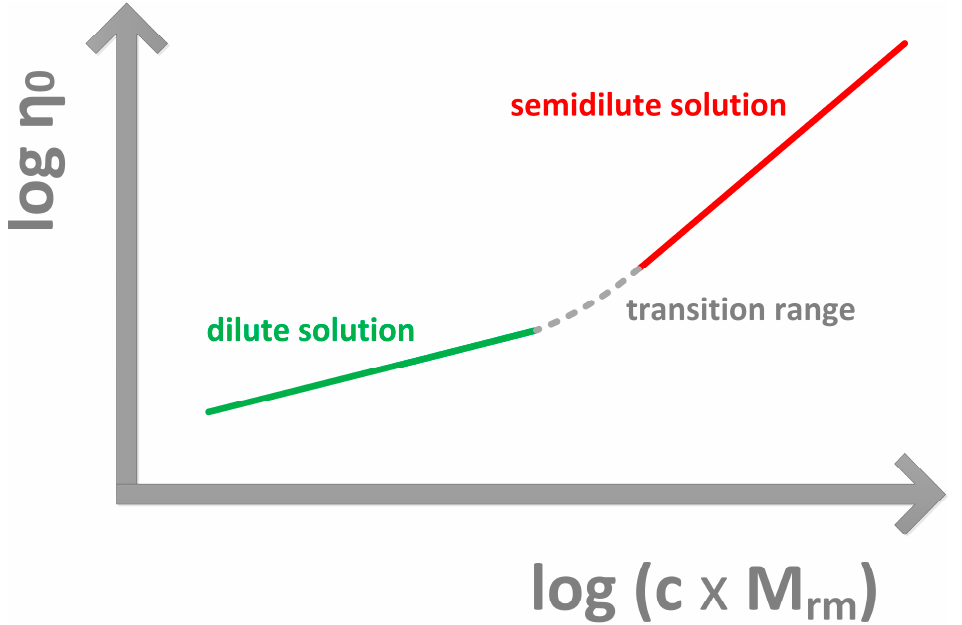
Figure 1. Illustration of the dependence of zero shear viscosity η 0 from the product of concentration and average molecular mass (c × M rm ) of solutions of an ideal linear